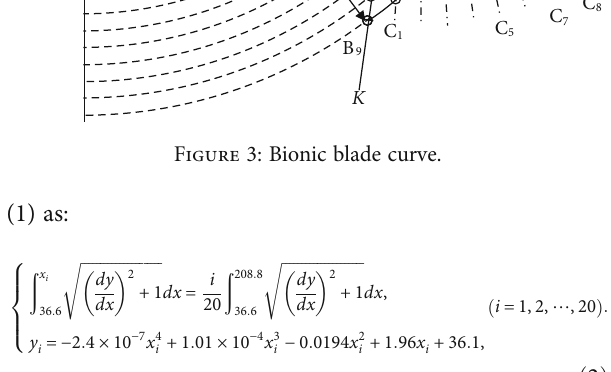
Figure 3: Bionic blade